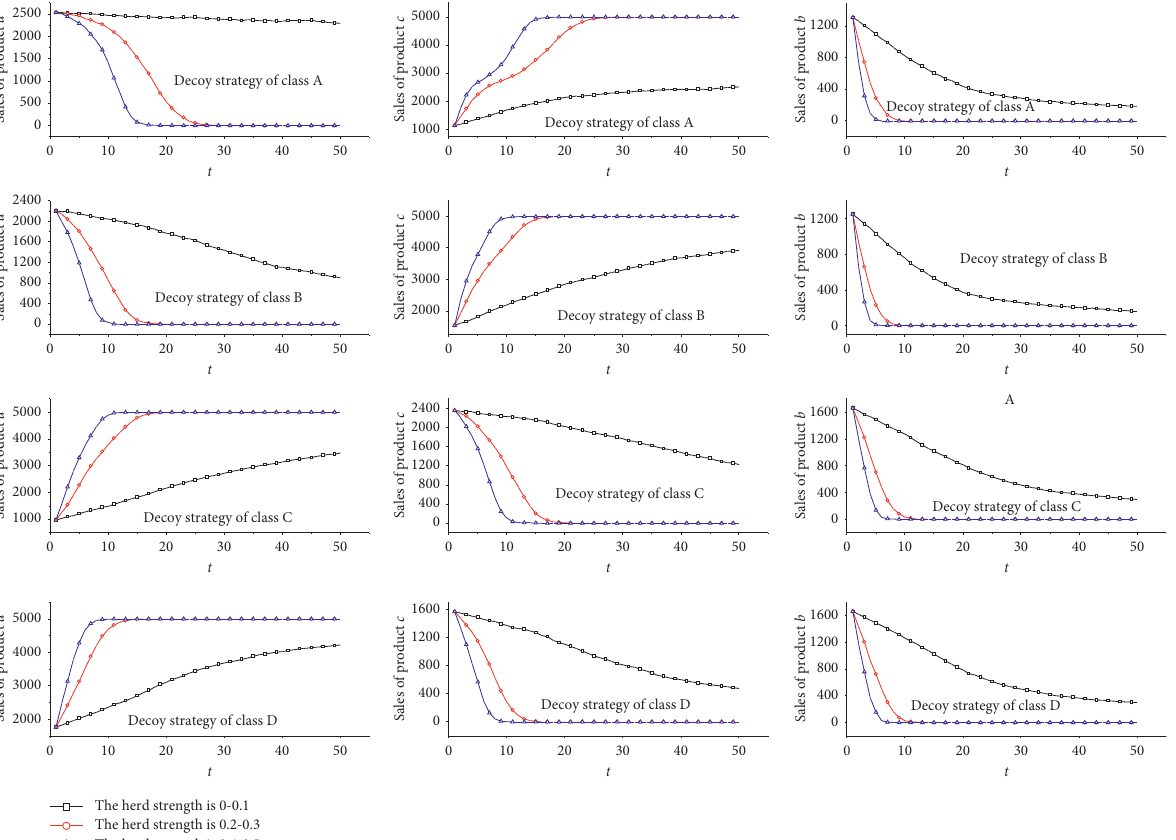
Figure 12: Evolution trend for sales of products a , c , and b under the four kinds of true decoy strategies in scenarios with different herd